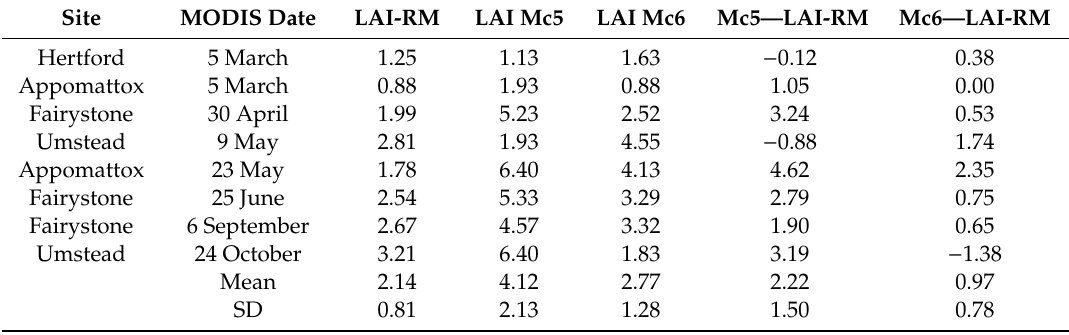
Table 6. MODIS LAI (Mc5 and Mc6) comparisons to LAI-RM.